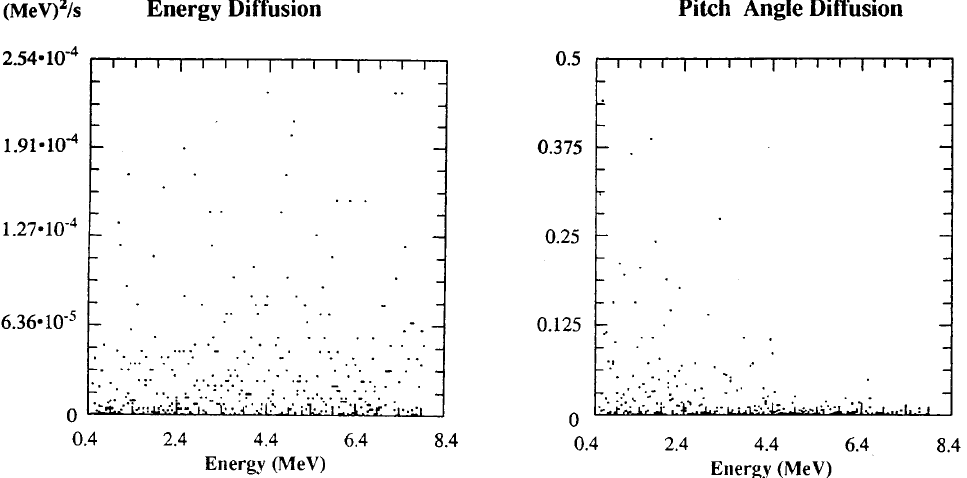
Fig. 3. Di(cid:128)usion in energy and in pitch angle for several hundreds of electrons as a function of the initial